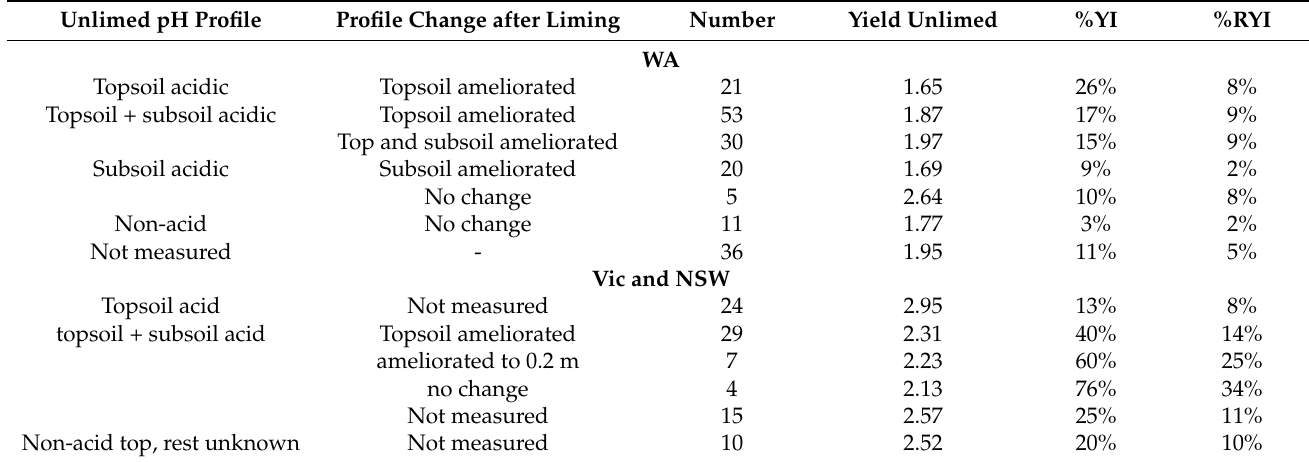
Table 5. The effect of soil pH profile type and change in pH following liming on the unlimed yield and yield increase from liming (as %yield and %increase in relative yield) in trials from WA and NSW and VIC. Unlimed pH